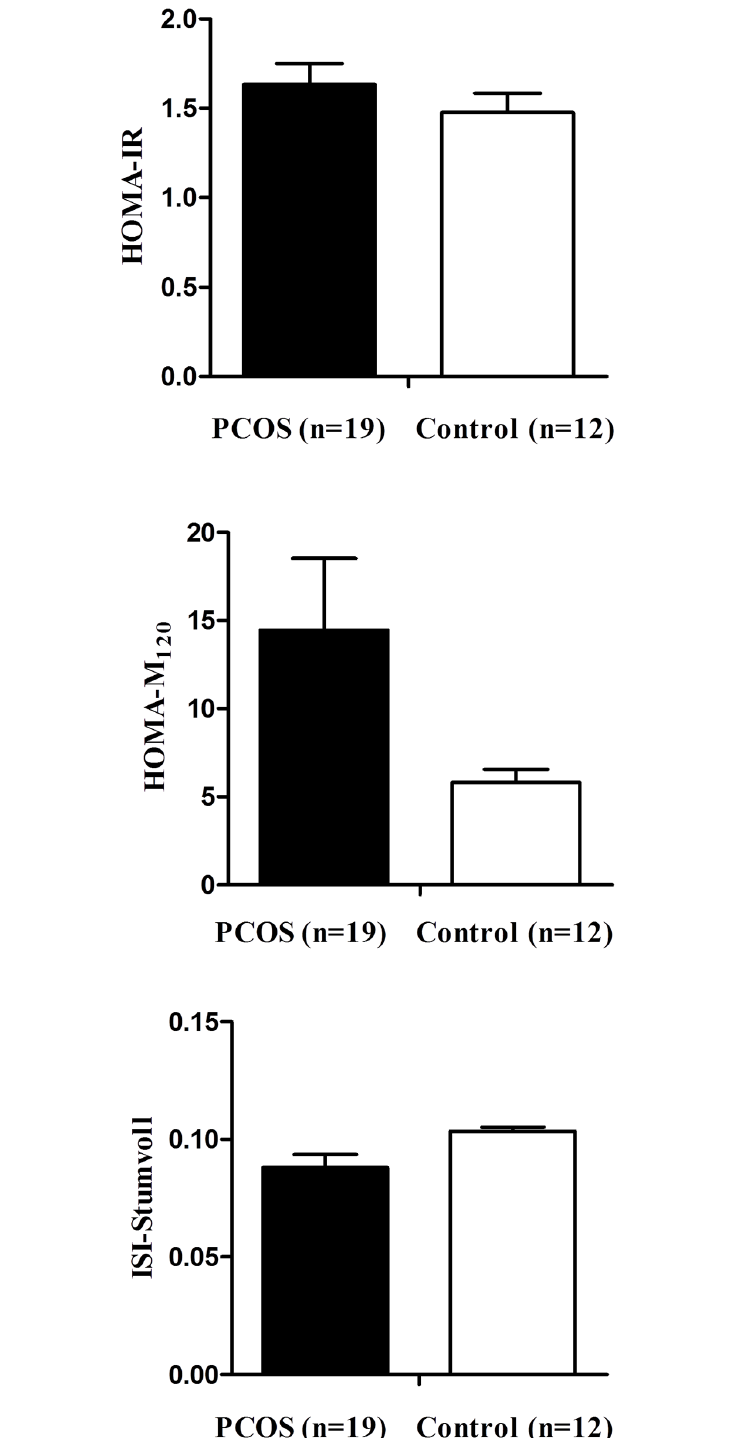
Fig 2. Comparison of insulin resistance indices in lean women with increased β -cell function. * P < 0.05 vs. controls. PCOS, polycystic ovary syndrome; HOMA-IR, homeostasis model assessment of insulinresistance; ISI, insulinsensitivity